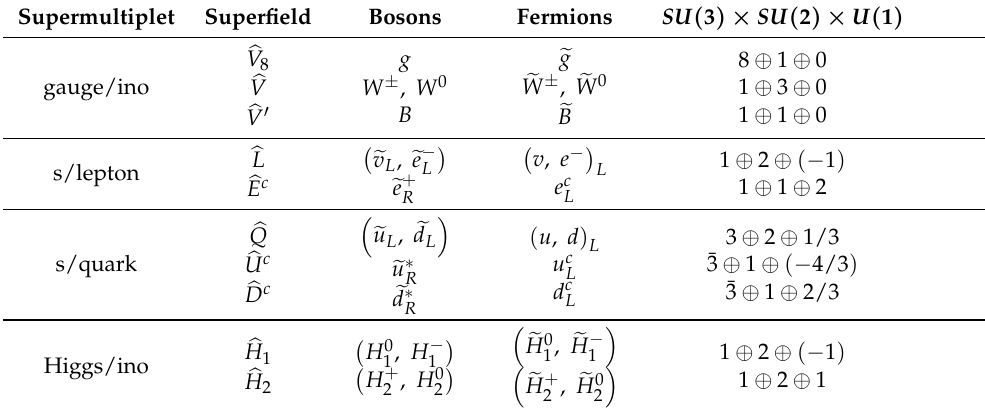
Table 1. MSSM spectrum fields and their SU ( 3 ) × SU ( 2 ) × U ( 1 ) quantum numbers. In this table, only one generation of leptons and quarks is exhibited. For each lepton and quark supermultiplet, there is a corresponding multiplet of scalar superpartners, while for the Higgs supermultiplet an antiparticle multiplet of charge-conjugated fermions is